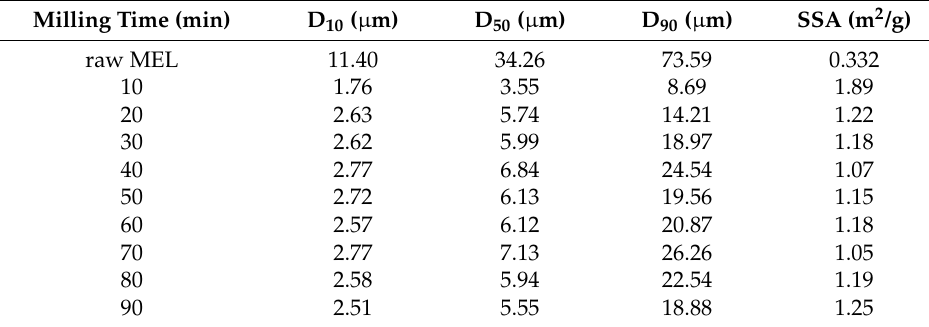
Table 1. MEL PSD and SSA in pre-dispersions containing water as dispersant.